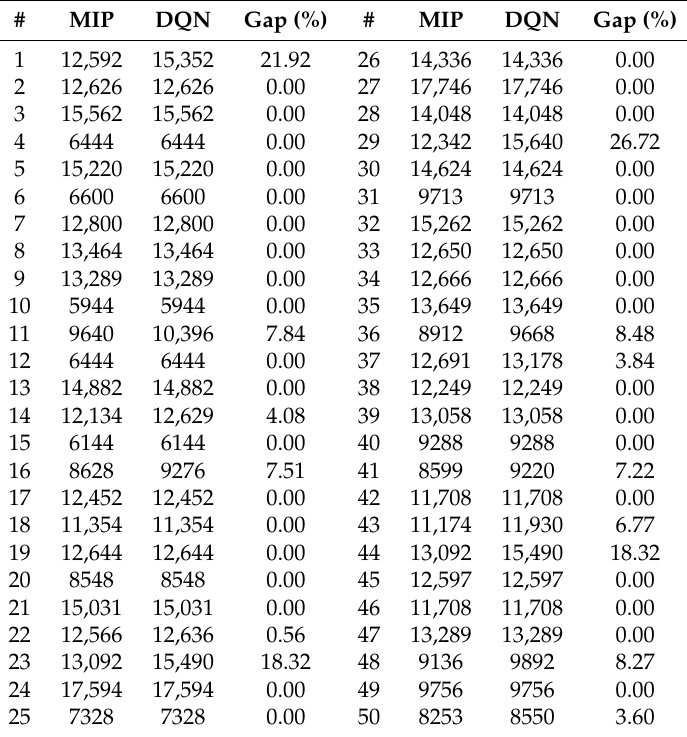
Table 3. Comparison on 50 3-train